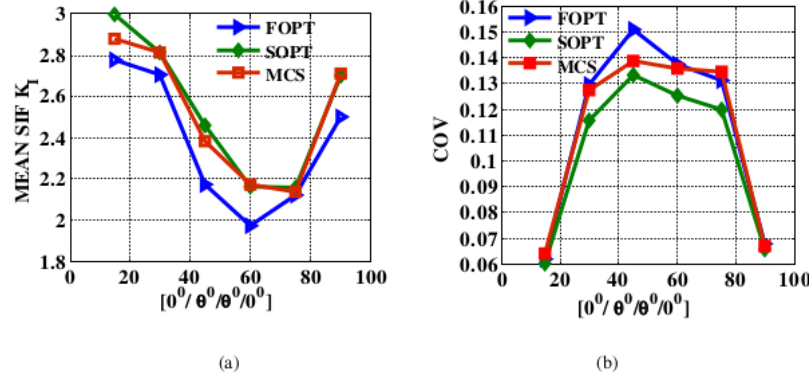
Figure 4: Effect of different lamination angles with random change in crack opening ( co ) on (a) mean of SIF K I and (b) COV of SIF K I .